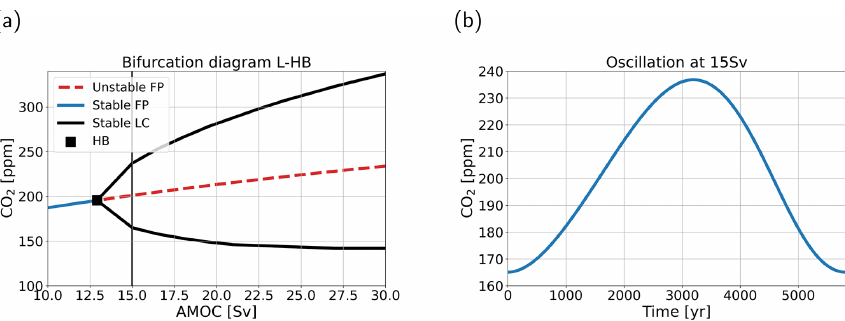
Figure 5. (a) Bifurcation diagram for case L-HB in atmospheric p CO 2 –AMOC space. Blue solid lines denote stable steady states (or fixed points, FPs), red dashed lines indicate unstable steady states, black solid lines indicate a stable limit cycle (LC), and the black square denotes the location of a (supercritical) Hopf bifurcation (HB). (b) The oscillation of atmospheric p CO 2 in parts per million versus time in years for the limit cycle at 15Sv. The period is 5814 years.